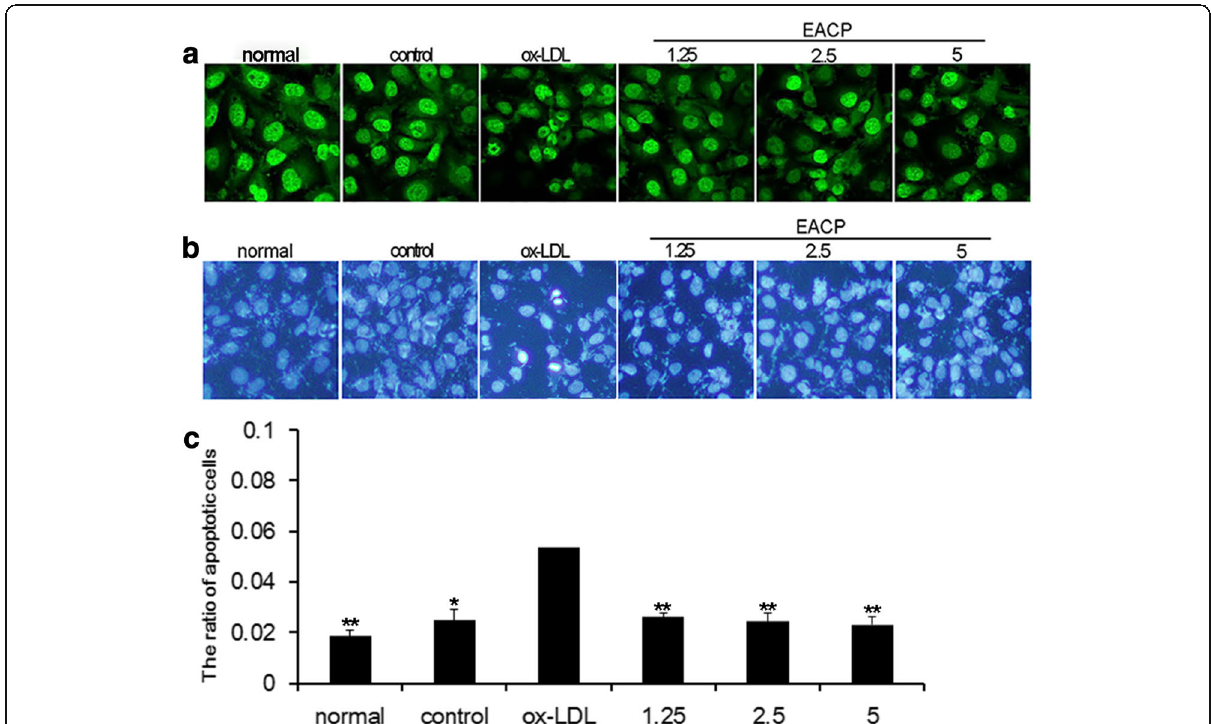
Fig. 2 EACP inhibited ox-LDL induced apoptosis in ox-LDL induced HUVECs injury. a , AO staining showed treatment with EACP (1.25, 2.5 and 5 μ g/mL) depressed nuclear condensation and fragmentation in ox-LDL induced HUVECs. b , Hoechst 33,258 staining suggested that treatment with EACP inhibited apoptosis in ox-LDL induced HUVECs. c , Quantification of relative apoptosis rate in ox-LDL induced HUVECs. ( * P < 0.05, ** P < 0.01 vs ox-LDL group, n = 3). Data are means ±